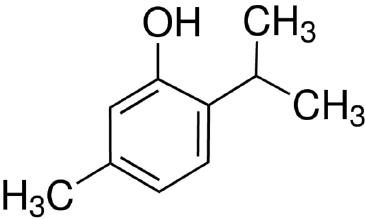
Figure 1. Chemical structure of thymol.